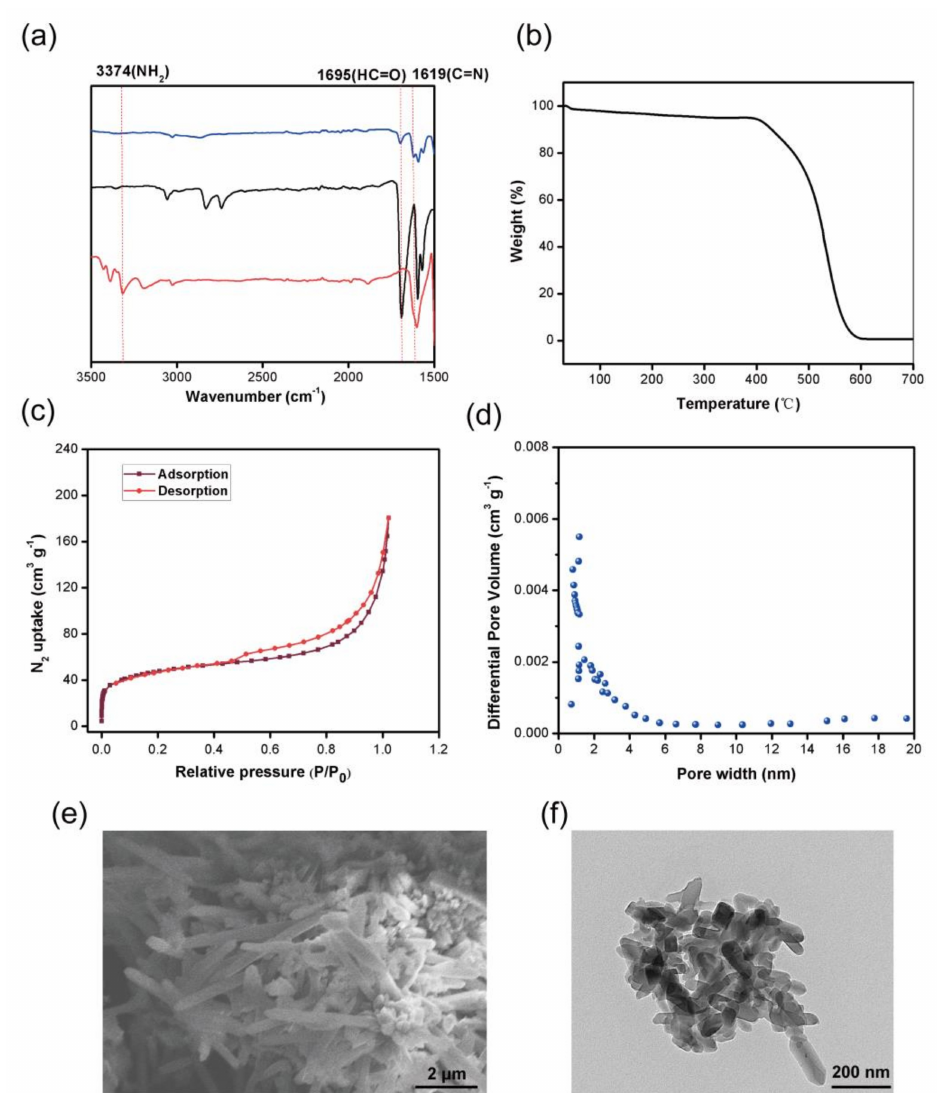
Figure 1. Characterization of the imine-based porous 3D COP. ( a ) FTIR spectra comparison of 3D COP (blue), TFPM (black), and DABP (red); ( b ) TGA analysis; ( c ) N 2 absorption–desorption isotherms; ( d ) pore width distribution; SEM ( e ) and TEM ( f ) images of 3D COP. This indicates that 3D COP exhibits rod-like